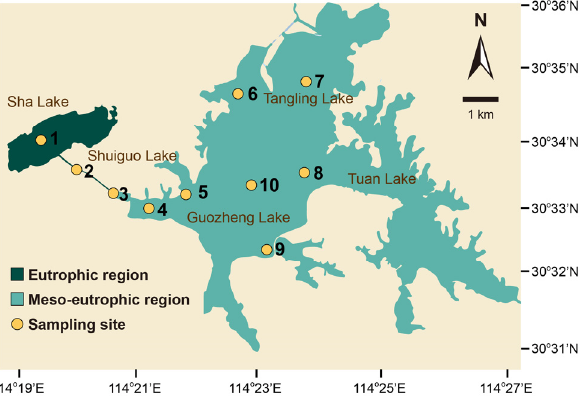
Figure 1. Location of sampling sites. The numbers (1–10) represent the 10 sampling